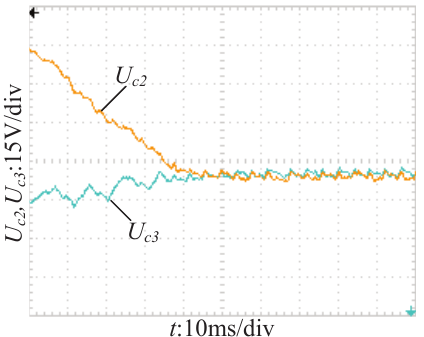
Figure 24. Output current waveform when duty cycle and modulation ratio change.